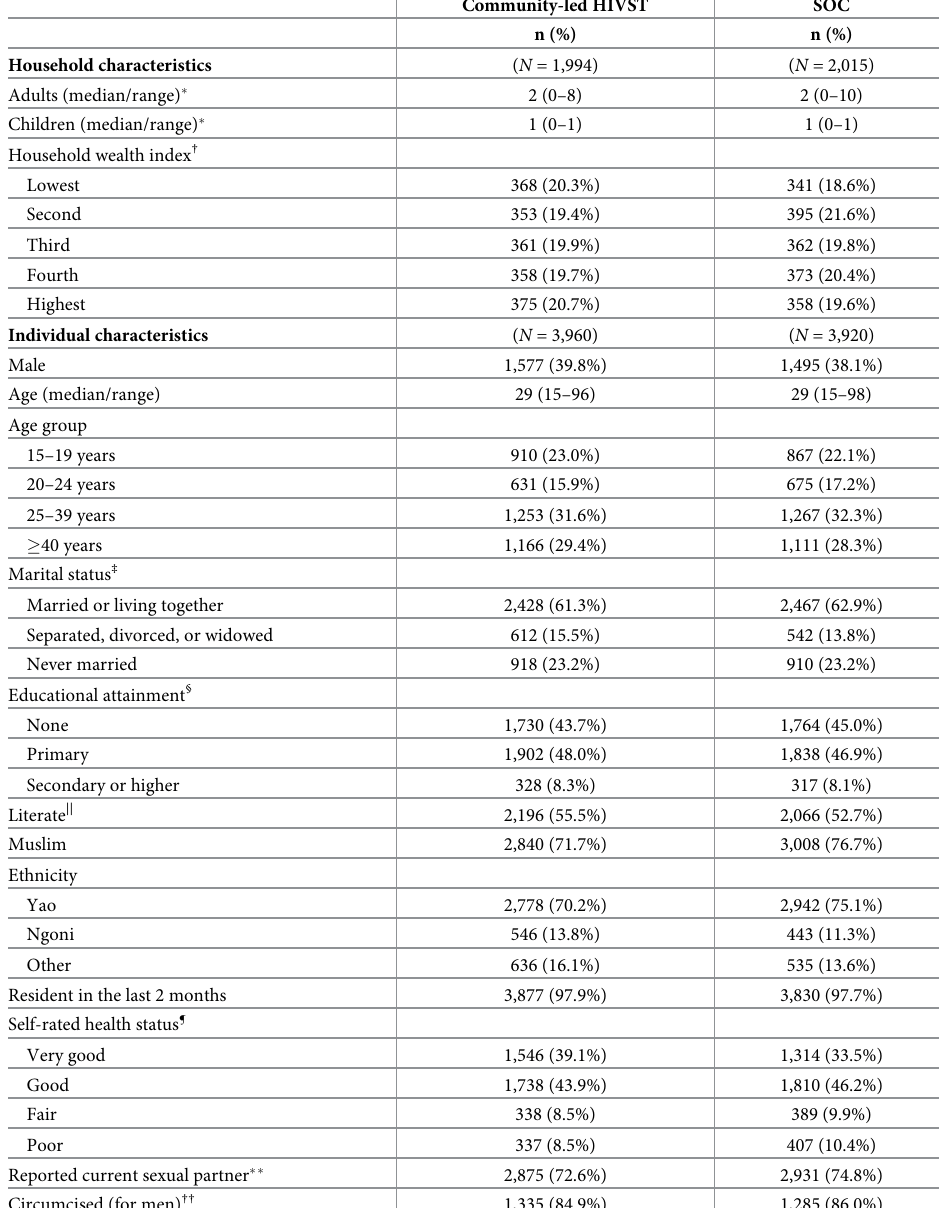
Community-led HIVST SOC